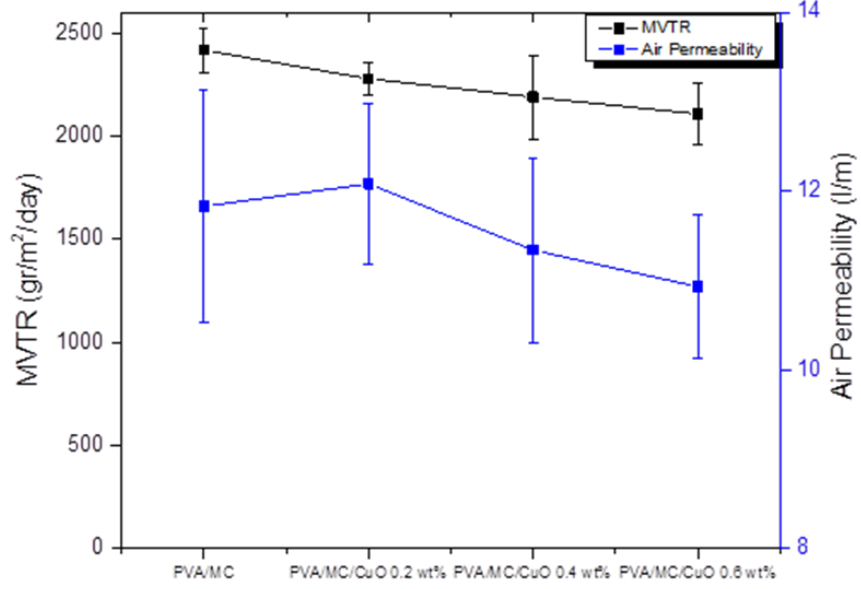
Figure 7. Air permeability and moisture vapor transport rate of the prepared nanofibers .